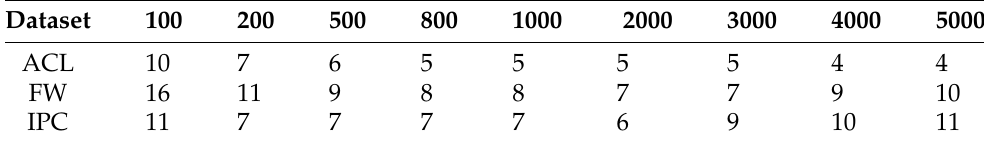
Table 1. Performance of different AVE Form thresholds (WC Form threshold: 10,000, Form Switch threshold: 2000).